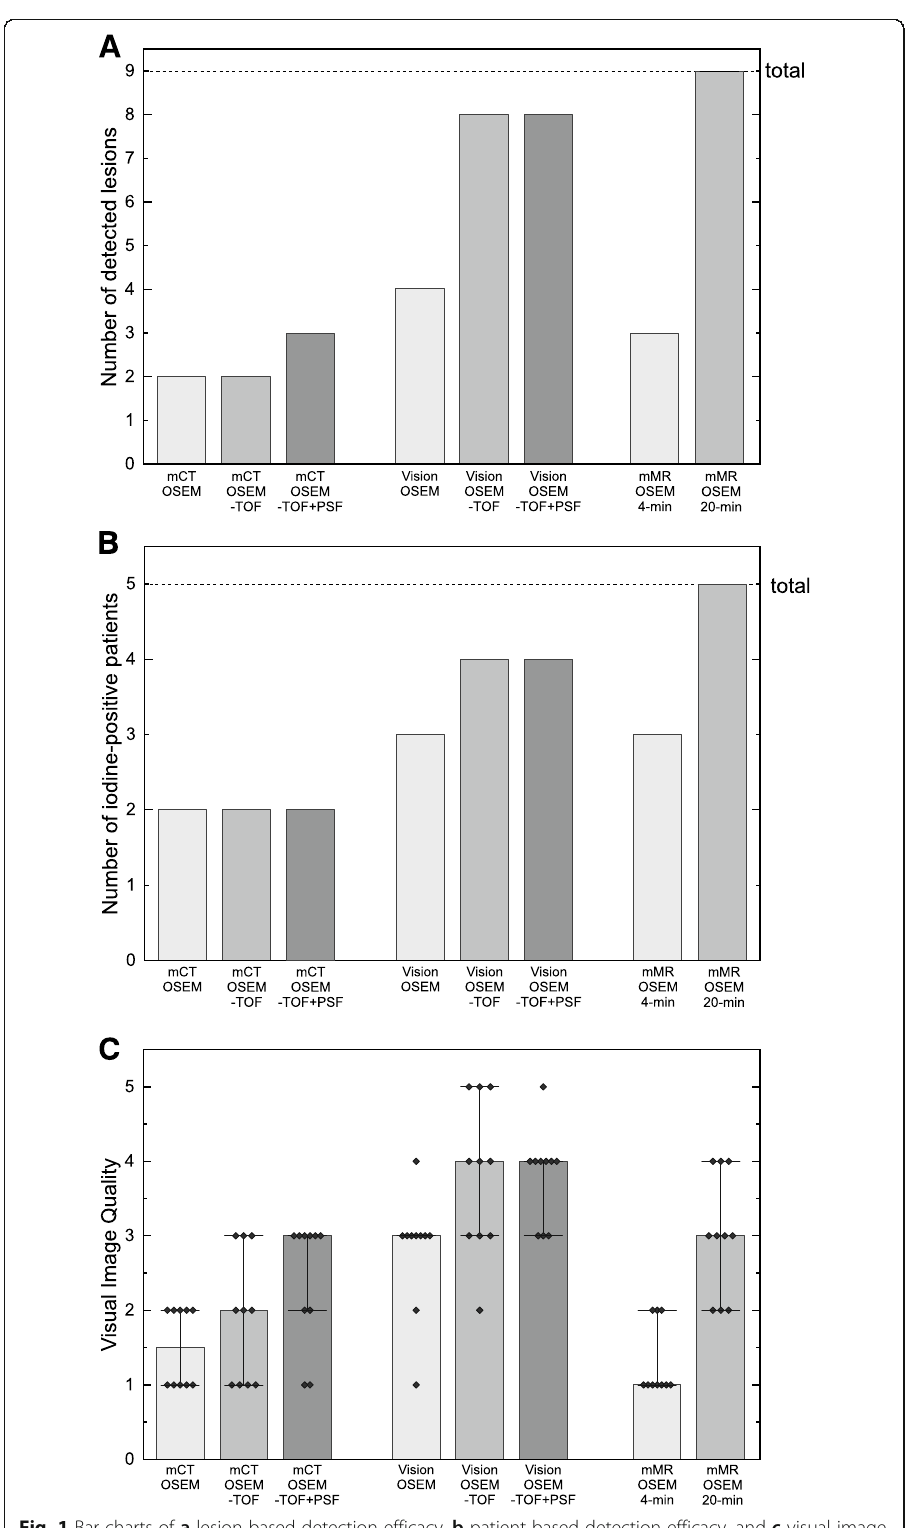
Fig. 1 Bar charts of a lesion-based detection efficacy, b patient-based detection efficacy, and c visual image quality (diamonds: data points, bar: median, whiskers: quartiles). The detection efficacy was evaluated using as reference the five-fold prolonged scan duration image acquired on the PET/MR